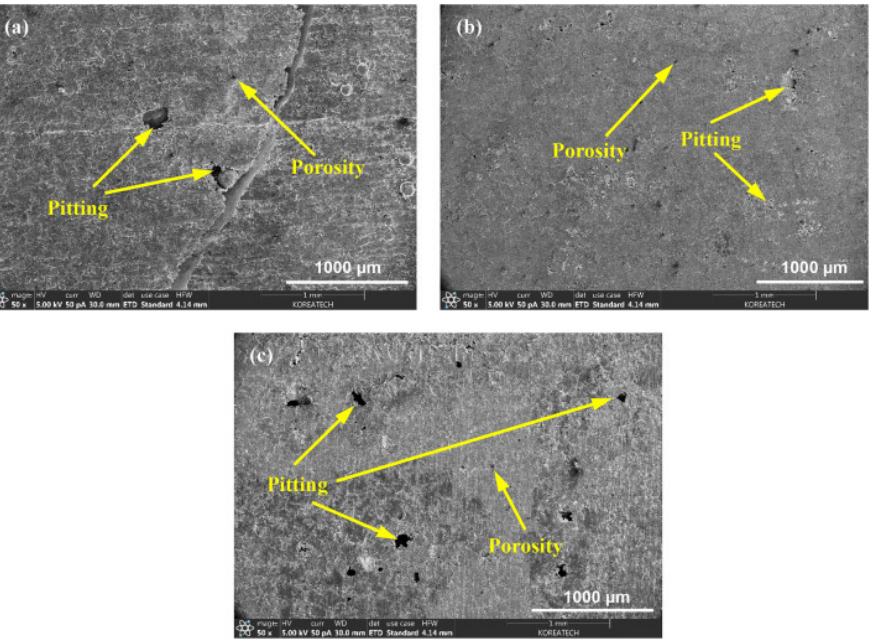
Figure 17. The pitting corrosion characteristics of ( a ) SLM 316L SS, ( b ) SLM 316L SS + UNSM, and ( c ) SLM 316L SS + UNSM + HT. Reprinted with permission from ref. [116]. Copyright 2020, Elsevier.